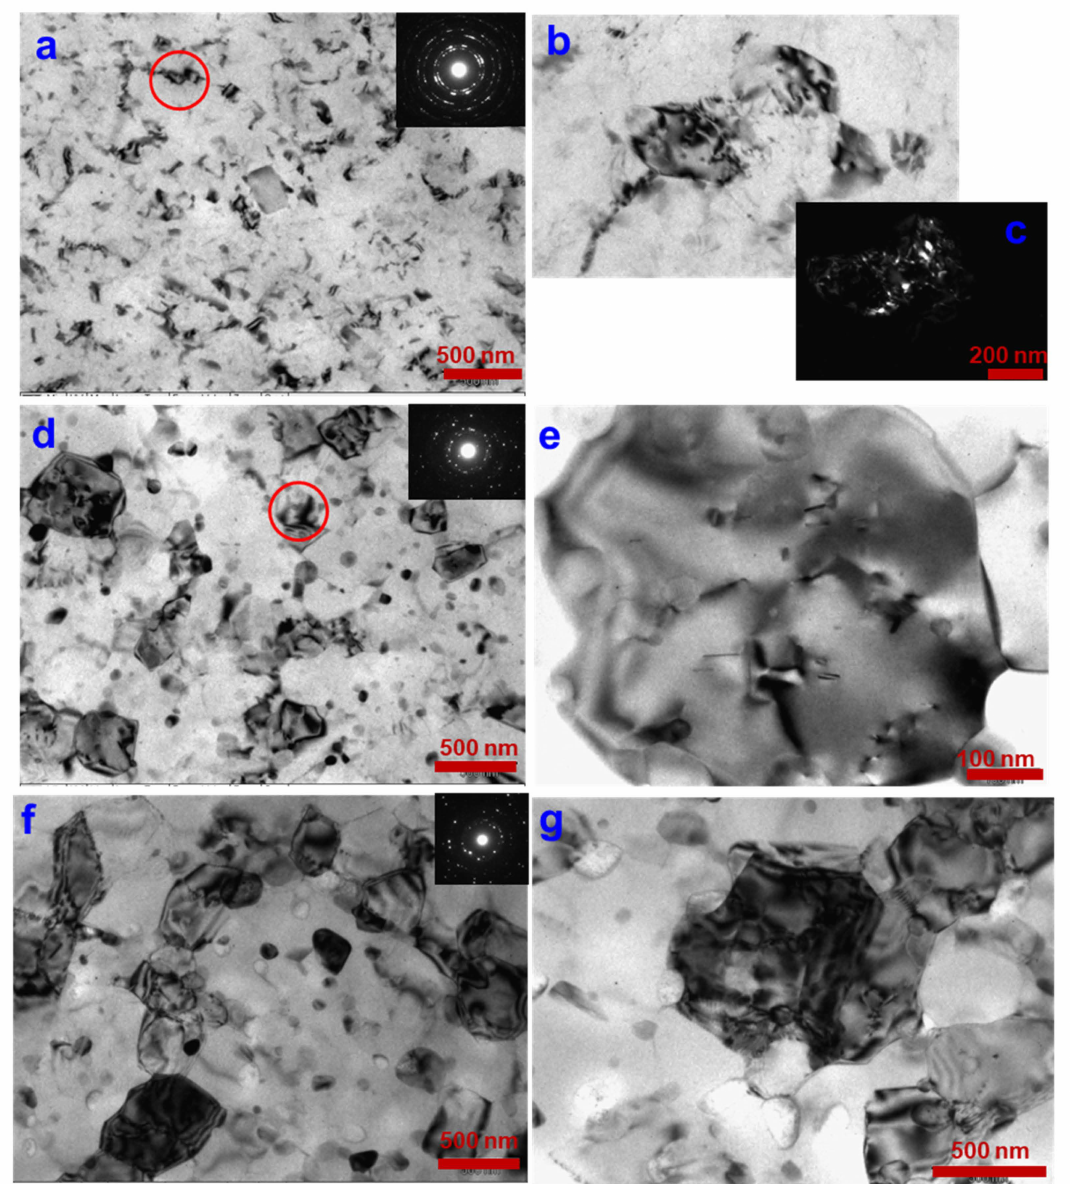
Figure 1. Microstructure after HPT ( a – c ); after HPT + annealing at 190 ◦ C ( d , e ) and after HPT + an- nealing at 270 ◦ C ( f , g ). The two grains marked by a red circle in Figure 1a are shown in a larger magnification in Figure 1b. The grain marked by a red circle in Figure 1d is shown in a larger magnification in Figure